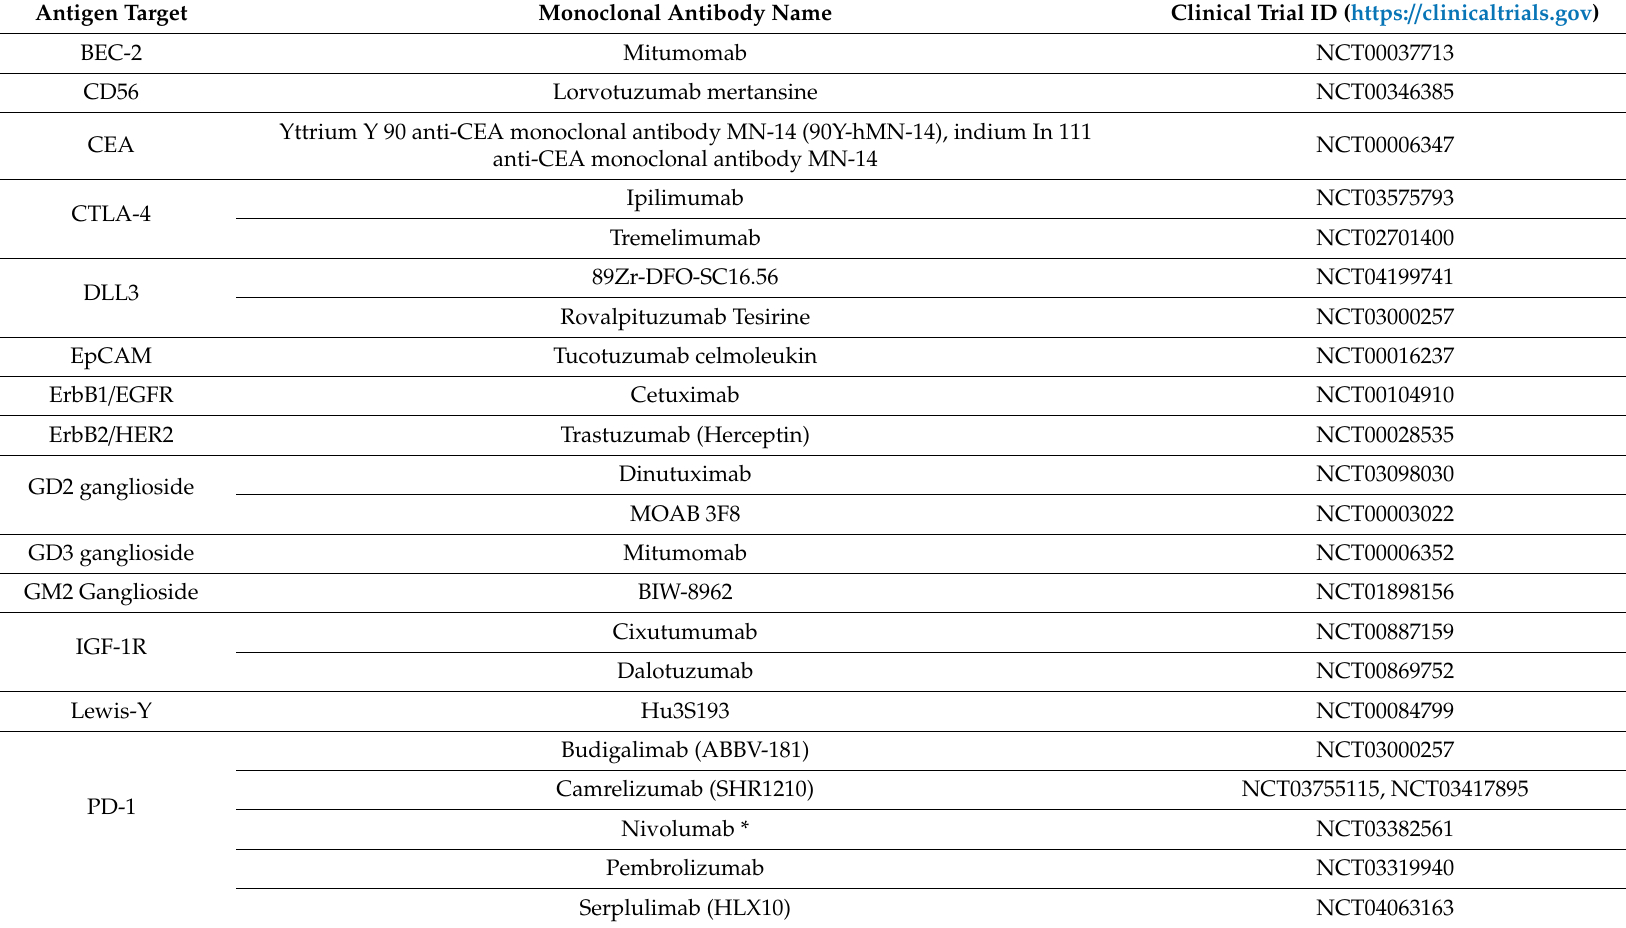
Table 2. SCLC tumor-associated antigens targeted by monoclonal antibodies that are currently being tested in clinical